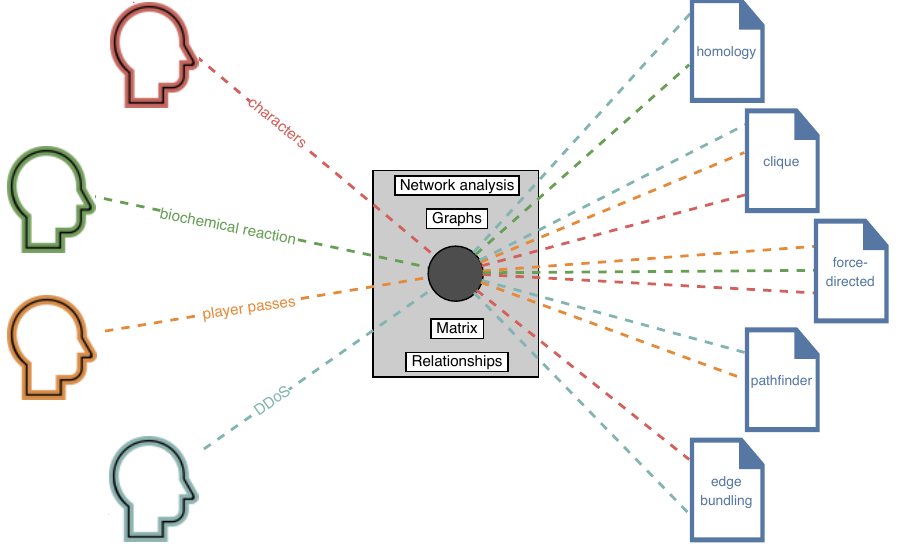
Figure 1. Document exploration model for four different interdisciplinary visualization researchers in the humanities (red), bioinformatics (green), sports science (orange), and security (teal) domains accessing a large collection of research papers containing unknown, potentially interesting techniques (right, in blue) that could be applied to solve their domain-specific problems (e.g., characters, biochemical reaction). Each problem is typically related to the same intermediate concepts (shown at the center), which are the users’ entry points to the collection. This idea is employed in our study to detect similarities between the different communities of practice and bring them